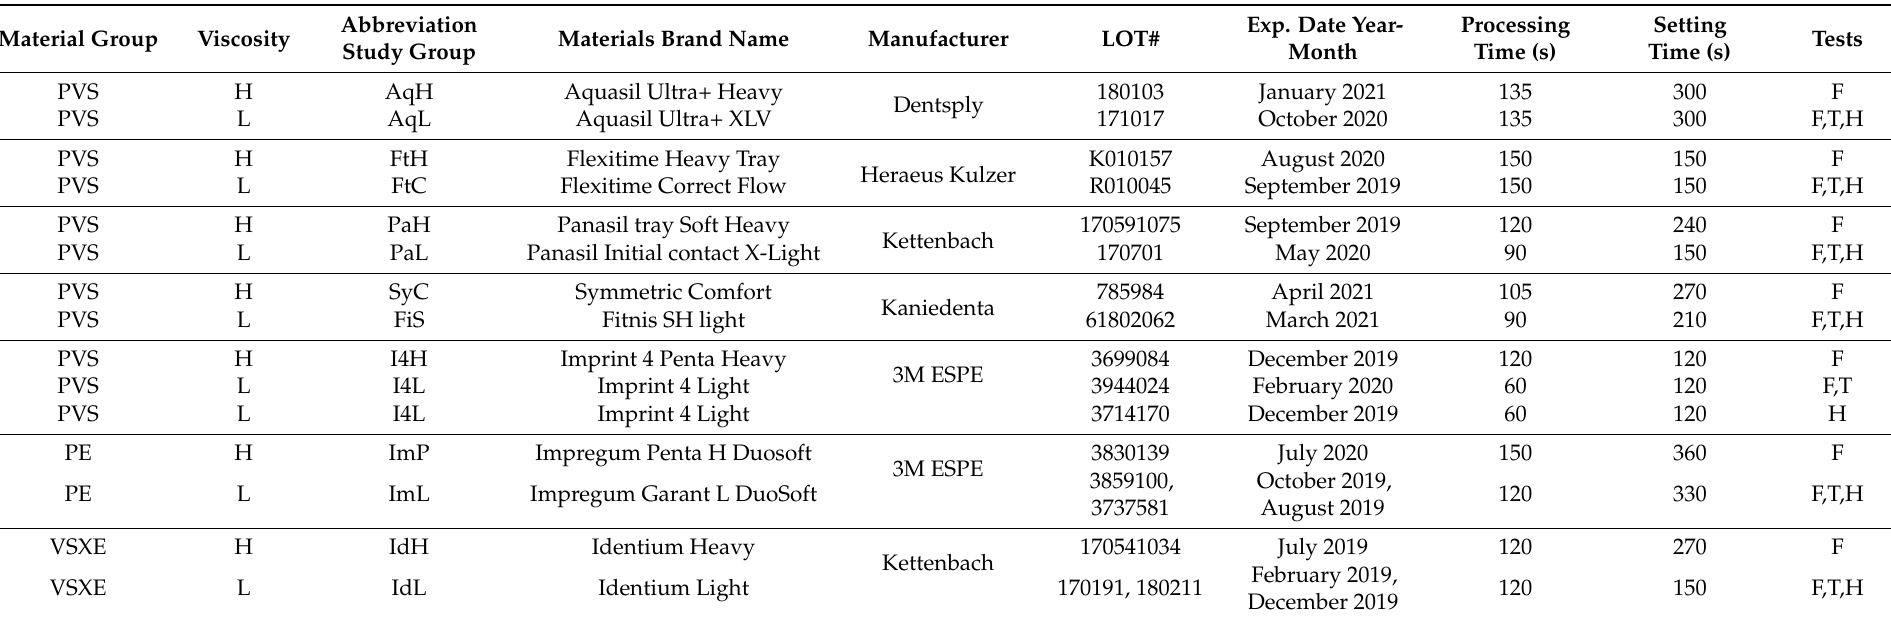
Table 1. Overview of elastomer properties and the performed tests. Material groups: PE = polyether, PVS = polyvinylsiloxane, PVXE = polyvinylsilaxonether. Viscosity: L = light-body, H = heavy-body. Tests: F = flowability using shark-fin; T = tear strength applying DIN 53504; H = hydrophilicity using contact angle of 1 and 3 s old drops. Corresponding materials for wash impression technique are grouped in one row (e.g.,